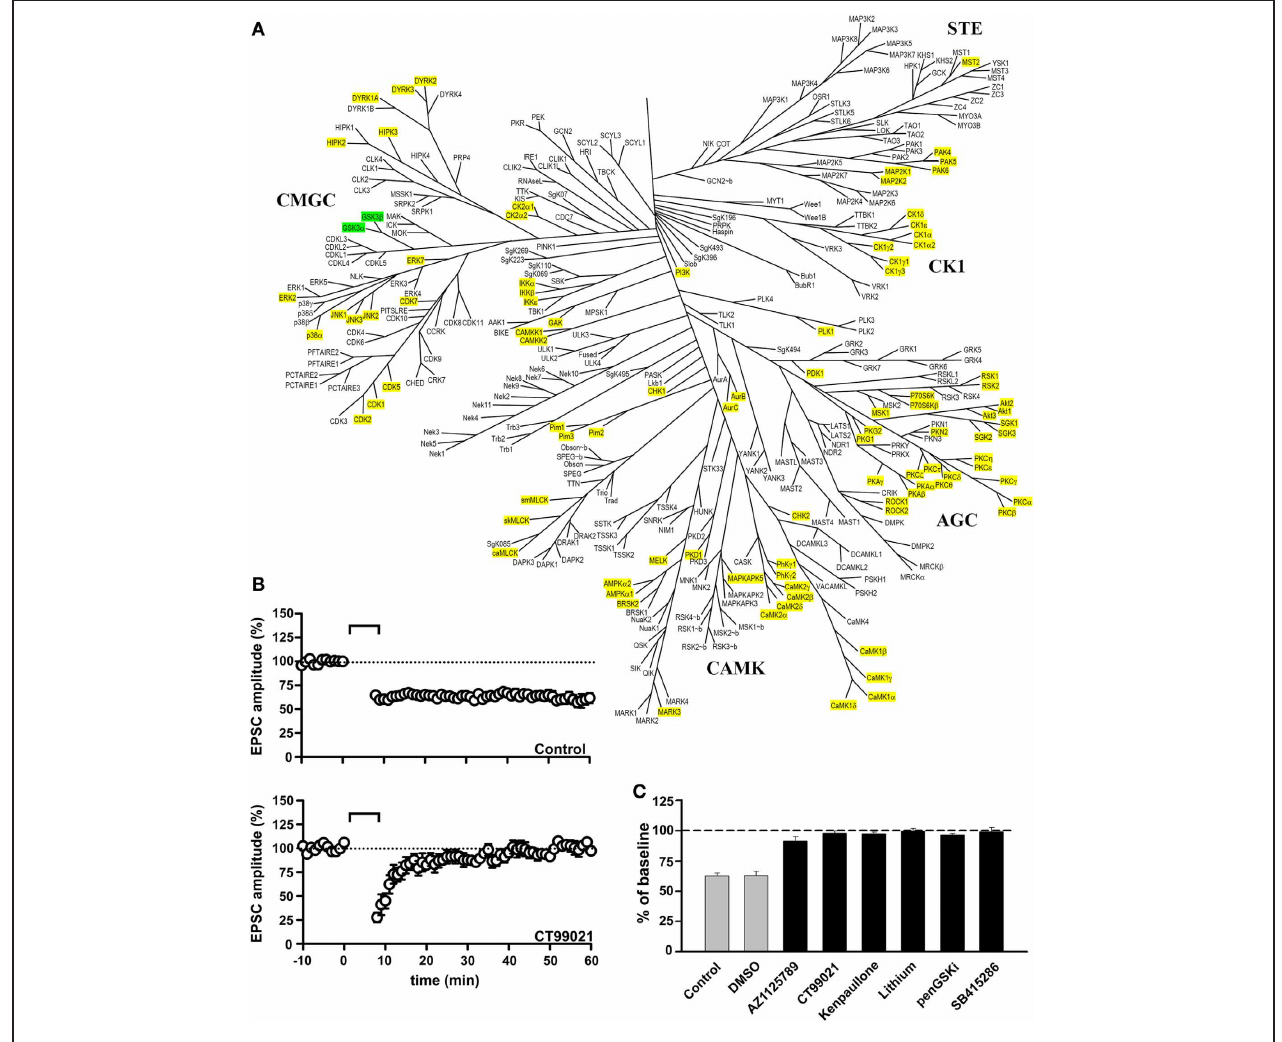
FIGURE 1 | GSK-3 inhibitors block the induction of NMDAR-LTD. (A) Family tree of Ser/Thr protein kinases in the human genome (modified from Manning et al., 2002). The two isoforms of GSK-3 ( α and β ) are highlighted in green. The kinases that were excluded from having a role in the induction of NMDAR-LTD, based on inhibitor